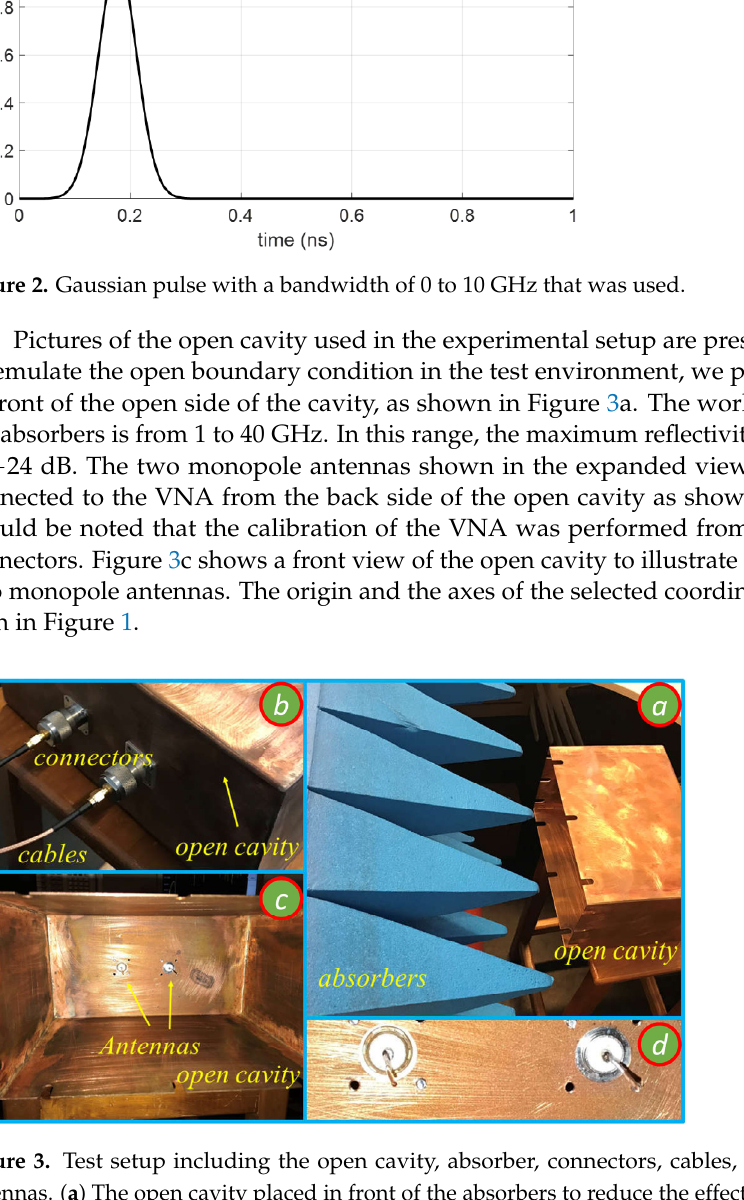
Figure 3. Test setup including the open cavity, absorber, connectors, cables, and two monopole antennas. ( a ) The open cavity placed in front of the absorbers to reduce the effects of reflections from the environment on the experimental results. (b ) The cables and connectors used to connect the two monopole antennas to the VNA. ( c ) A front view of the open cavity, including the two monopole antennas inside it, and ( d ) an expanded view of the two monopole antennas.